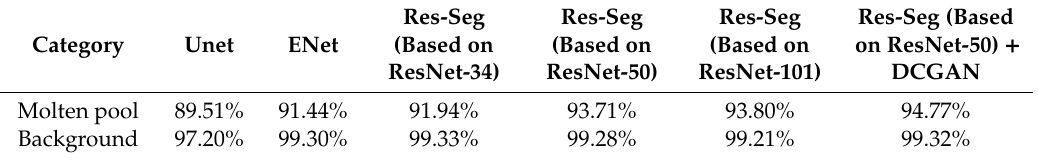
Table 2. Test set segmentation accuracy.